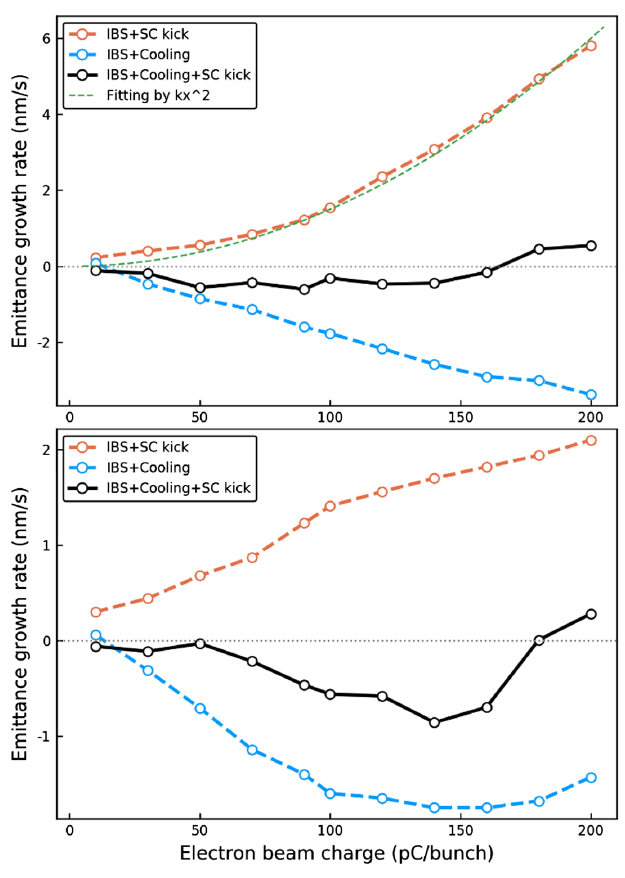
FIG. 10. Dependency of the emittance growth rate on the electron beam charge in simulation with (bottom) and without (top) considering the variable profile of the electron beam along the CS due to the SC effect. (Alignment errors, 0 mm – 75 μ rad.)